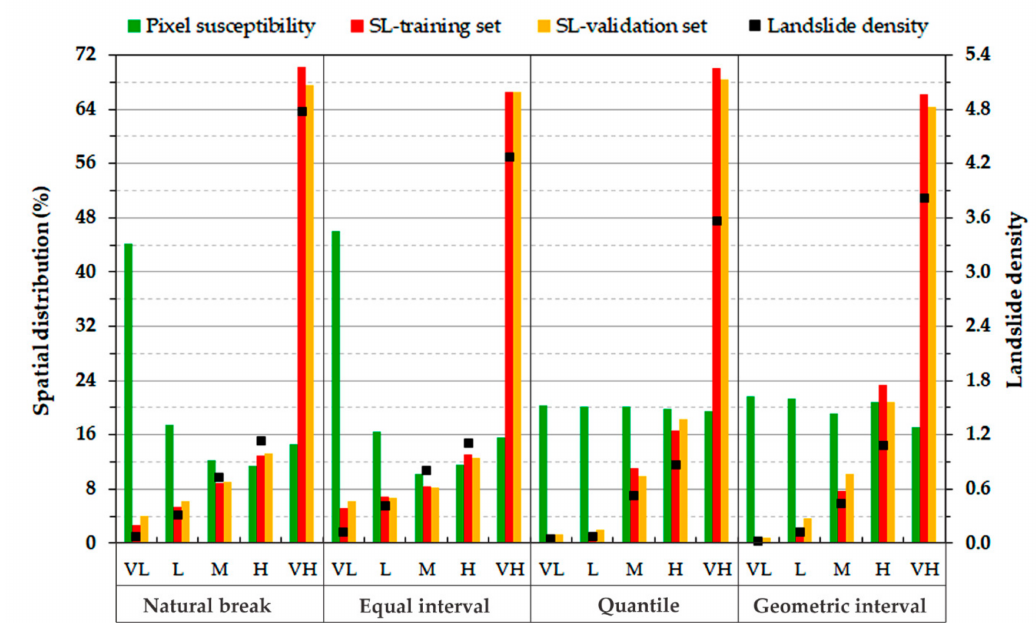
Figure 6. Comparison of the classification methods tested to select the best classification method for draw the shallow landslide susceptibility map.